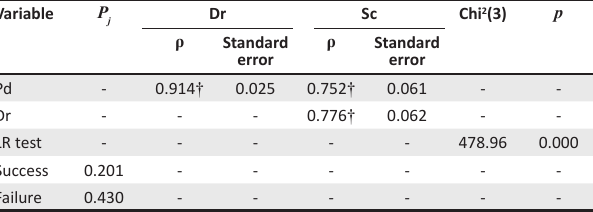
TABLE 2: Pairwise correlation matrix from the mvprobit estimation. Variable